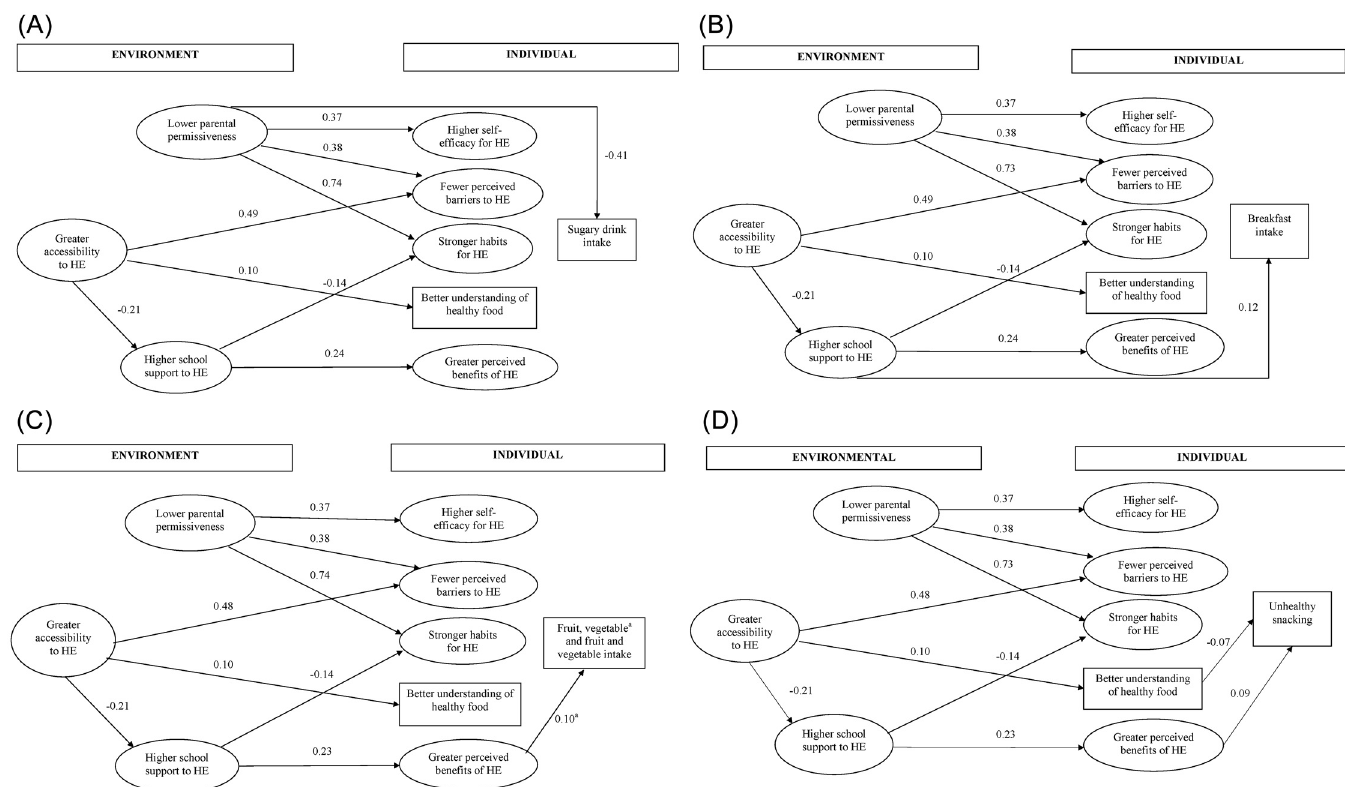
Fig 3. (A) Individual and environmental influences on sugary drink consumption. Only statistically significant paths at P < 0.05 are shown. Goodness of Fit- statistics: χ ²(303) = 630.18, p < 0.001; RMSEA = 0.038; NNFI = 0.92; CFI = 0.93, GFI = 0.93. HE: Healthy Eating. (B) Individual and environmental influences on breakfast consumption. Only statistically significant paths at P < 0.05 are shown. Goodness of Fit-statistics: χ ²(303) = 630.50, p < 0.001; RMSEA = 0.038; NNFI = 0.92; CFI = 0.93, GFI = 0.94. HE: Healthy Eating. (C) Individual and environmental influences on fruit, vegetable and fruit and vegetable consumption. Only statistically significant paths at P < 0.05 are shown. Goodness of Fit-statistics: χ ²(303) = 623.69, p < 0.001; RMSEA = 0.038; NNFI = 0.92; CFI = 0.93, GFI = 0.94. a significant pathway for vegetable intake only. HE: Healthy Eating(D) Individual and environmental influences on unhealthy snacking. Only statistically significant paths at P < 0.05 are shown. Goodness of Fit-statistics: χ ²(303) = 619.19, p < 0.001; RMSEA = 0.037; NNFI = 0.92; CFI = 0.93, GFI = 0.94. HE: Healthy